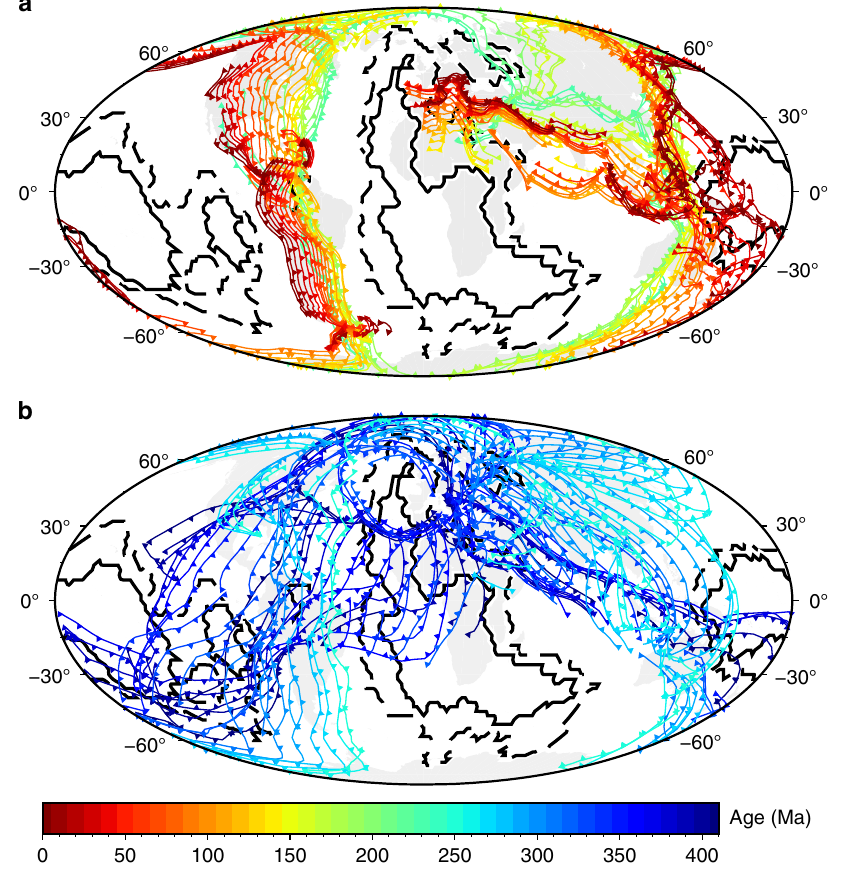
Fig. 2 Evolution of the location of subduction zones at 10 Myr intervals in global tectonic reconstructions. a Between 410 and 250 Myr ago based on the reconstruction of Domeier and Torsvik 2 , in a frame of reference corrected for true polar wander. b Between 230 Myr ago and present based on the reconstruction of Müller et al. 4 (reconstruction D in our original article 11 ). Present-day continents are shown as grey polygons . The solid black contour indicates a value of fi ve, and the dashed black contour a value of one in a vote map of the location of LLSVPs in tomography models